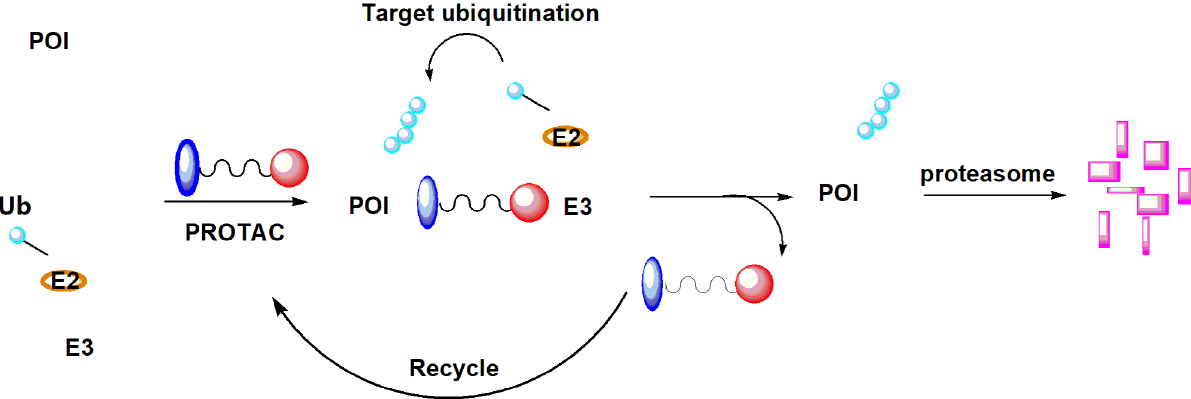
Figure 3. Mechanism of PROTAC-induced POI